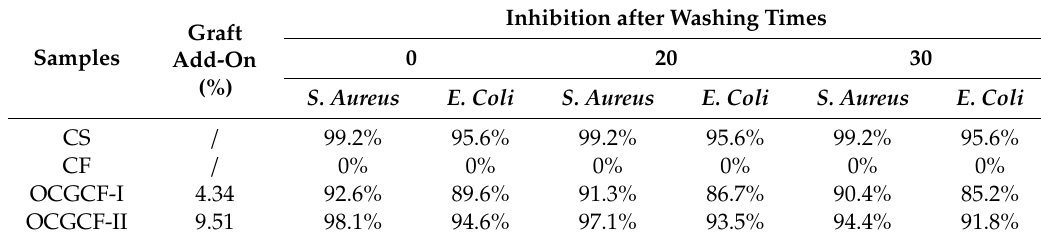
Table 2. Bacterial inhibition by the